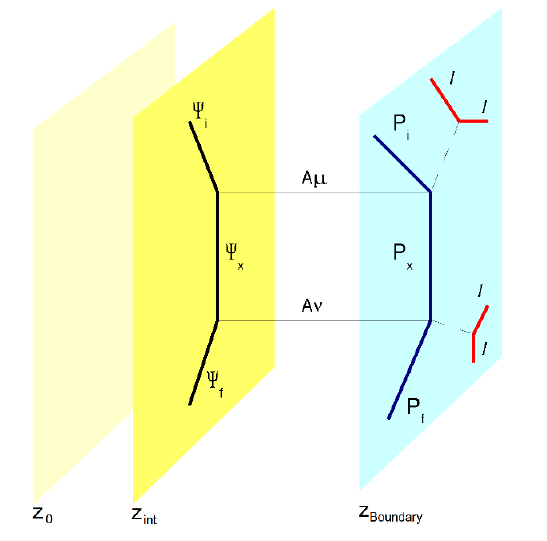
Figure 2. Schematic picture of the s -channel diagram corresponding to the holographic dual p description of forward Compton scattering in the 1 = (cid:21) (cid:28) x < 1 regime. The incoming and outgoing spin-1 = 2 hadrons with four-momenta P i and P f are represented by blue lines in the boundary theory. Their corresponding dual dilatino (cid:12)elds in the bulk are denoted by (cid:9) i and (cid:9) f , respectively. Gauge (cid:12)elds A (cid:22) and A (cid:23) couple to the J (cid:22) ( x ) and J (cid:23) (0) electromagnetic currents in the boundary gauge (cid:12)eld theory. z 0 is the IR cut-o(cid:11) and z int is where the graviphoton-dilatino interaction takes place. Red lines denote leptons ( l ), while dashed lines indicate virtual